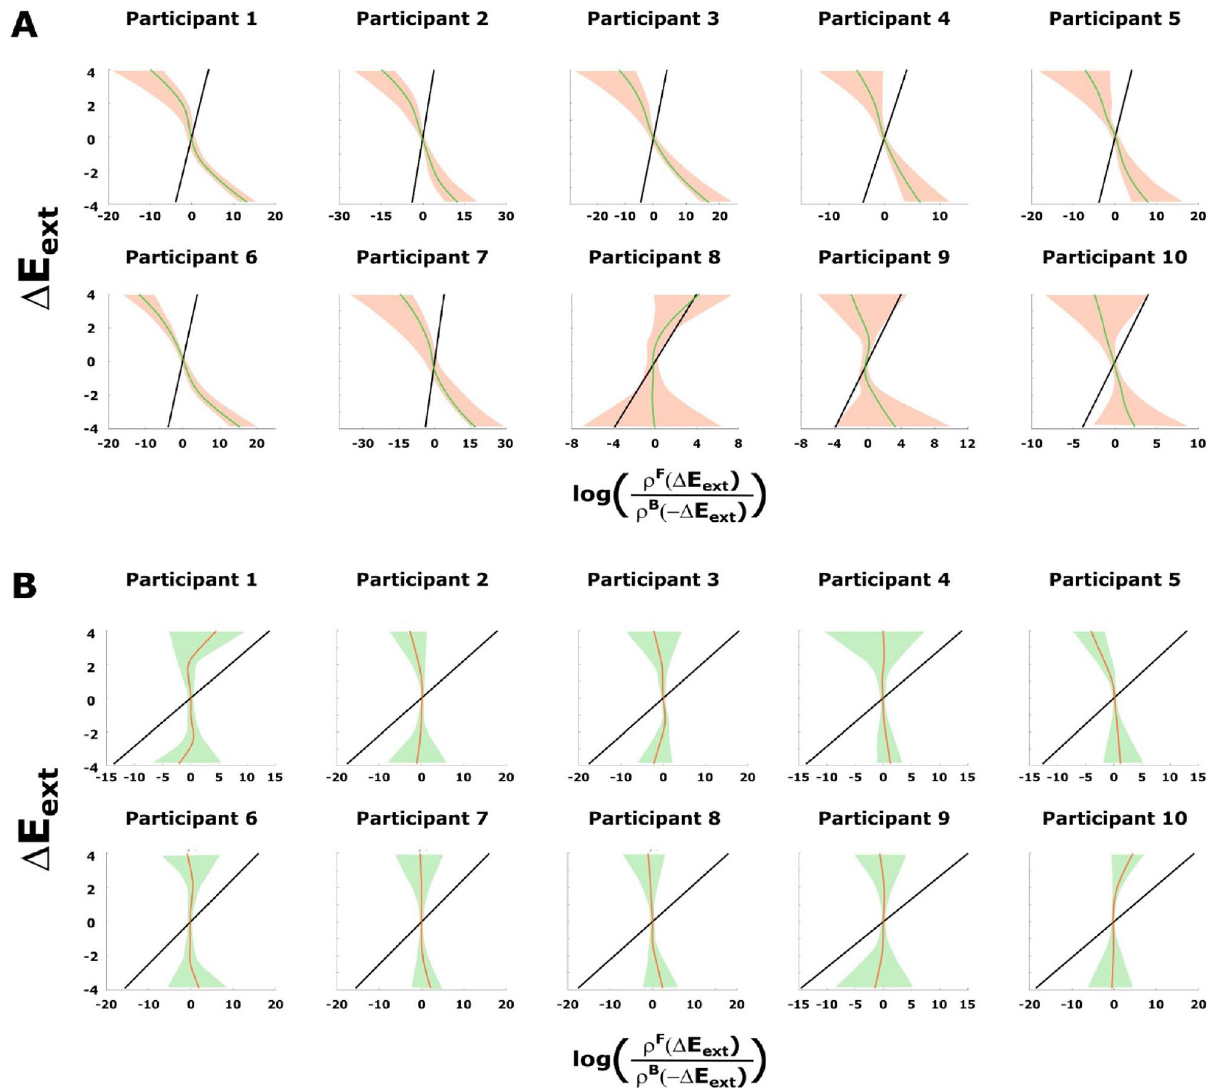
Figure 5. Control results for Crooks’ fluctuation theorem in two scenarios: ( A ) the sensorimotor loss behaves like a Mexican hat function and ( B ) the sensorimotor loss behaves as an exponential quadratic error but we sample the observed angles randomly with repetition. The black line is the theoretical prediction of Crooks’ fluctuation theorem (4) while the curves stand for the mean path after 1000 bootstraps of the observed driving error values. The shaded areas inside the graphs are the 99% confidence intervals which result from bootstrapping. Note, for simplicity, we assume β = 1 for all participants when using the Mexican hat to demonstrate that the result in ( A ) does not trivially hold for any cost function. For ( B ), we fit the parameters for each participant according to Sect.